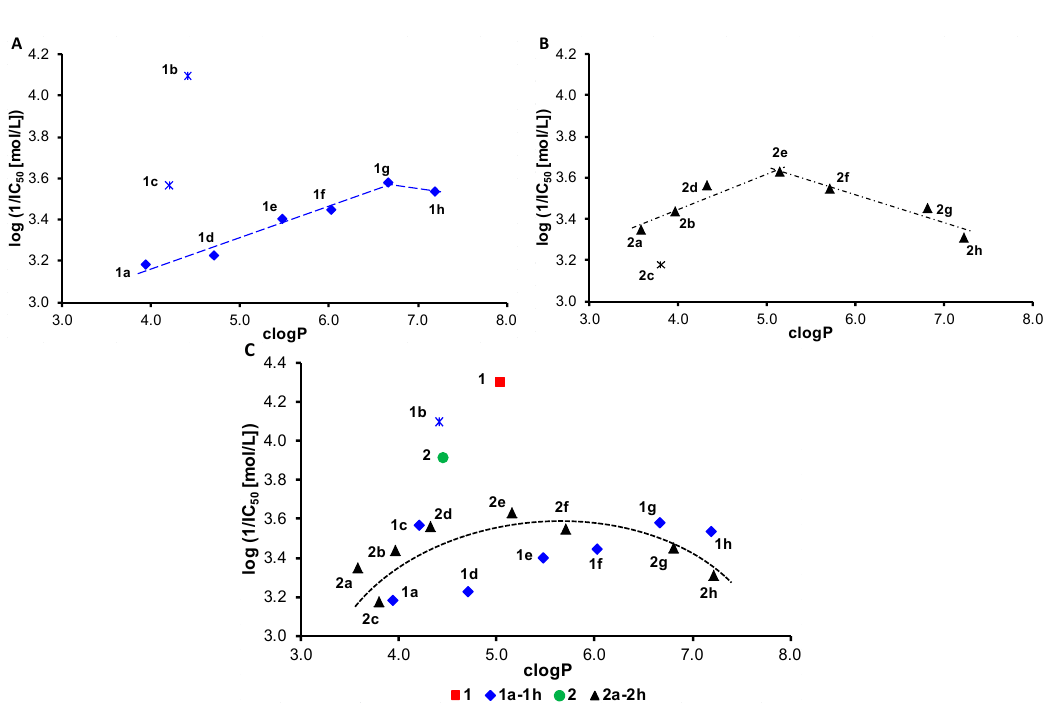
Figure 1. Dependence of PET-inhibiting activity log(1/IC 50 [mol/L]) of all discussed compounds 1a – 1h ( A ), 2a – 2h ( B ) and 1 – 2h ( C ) in spinach chloroplasts on lipophilicity expressed as clogP.